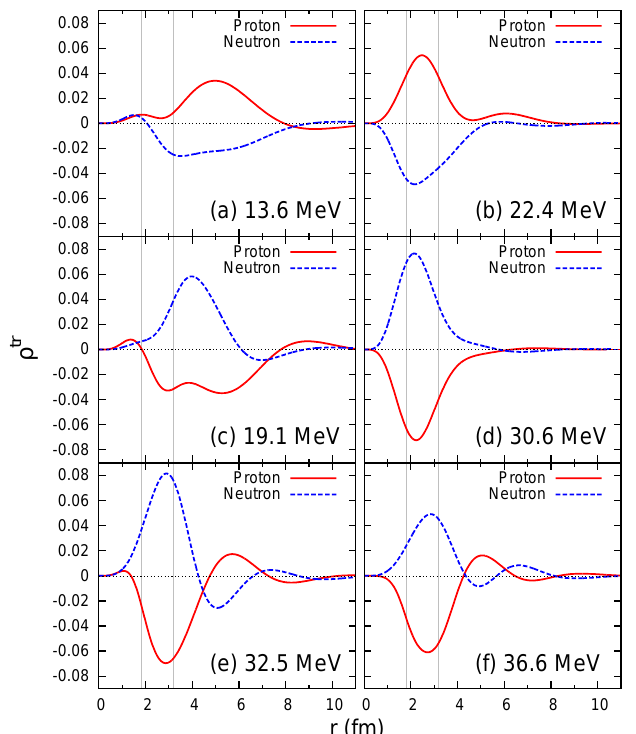
Figure 3: Transition densities for proton and neutron with u = 0.87 at (a) 13.6, (b) 22.4, (c) 19.1, (d) 30.6, (e) 32.5, and (f) 36.6 MeV. Vertical thin lines indicate theoretical nuclear radii, 4 He and 6 Li,